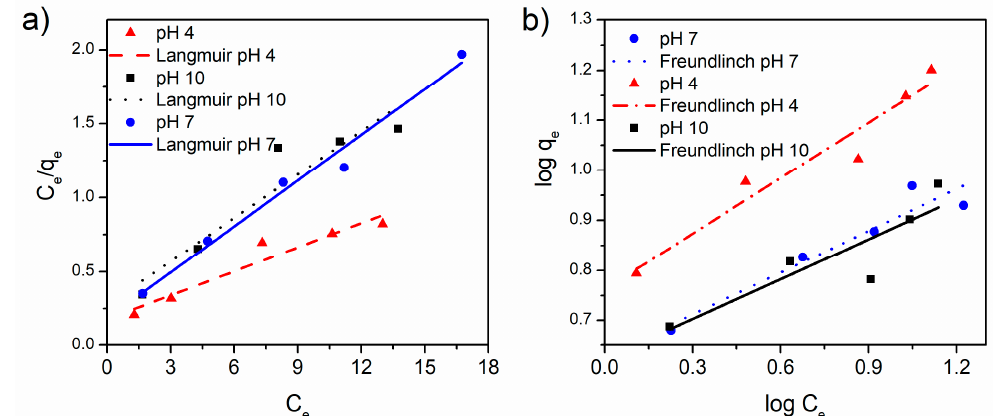
Figure 6. ( a ) Langmuir and ( b ) Freundlich model fitting for the adsorption of tetracycline on α -Fe 2 O 3 /RGO hybrid material. Experiment condition: 25 °C; 0.7 mg/mL of adsorbent. Table 2. Langmuir and Freundlich adsorption isotherms fitting parameters of tetracycline on α -Fe 2 O 3 / RGO and RGO as control. Adsorbent